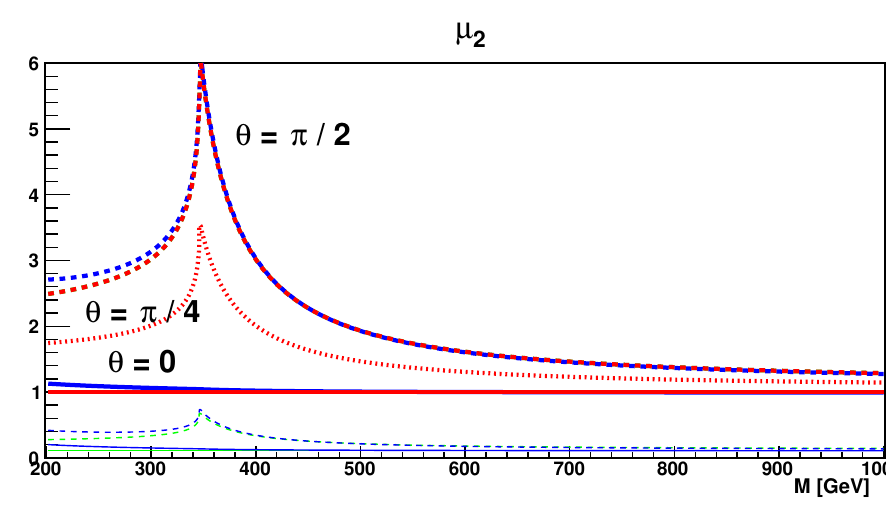
Figure 1 . Cross section ratios (cid:22) 2 for gg production of H 2 for (cid:22) (cid:26) q de(cid:12)ned by eq. (4.38). Here, for illustration we assume that phases of ^ (cid:26) q are the same for up- and down-type quarks, so (cid:18) u = (cid:18) d = (cid:18) . Red, heavy: general model with j ^ (cid:26) u j = j ^ (cid:26) d j = 1 with (solid) (cid:18) = 0, (dotted) (cid:18) = (cid:25)= 4 and (dashed) (cid:18) = (cid:25)= 2. Blue (green) heavy solid: Type II (Type I) for tan (cid:12) = 1 with (cid:11) 3 = 0 (so H 3 = A ). Dashed, same with (cid:11) 3 = (cid:25)= 2 (so H 2 = A ). Thin (blue and green) Type I and Type II with tan (cid:12) = 3. (The green curves, for Type I, are partly covered by the red and blue ones.) The spike at M = 2 m t originates from the function Re B of eq. (F.2) describing the pseudoscalar coupling. (cid:15) weak-boson